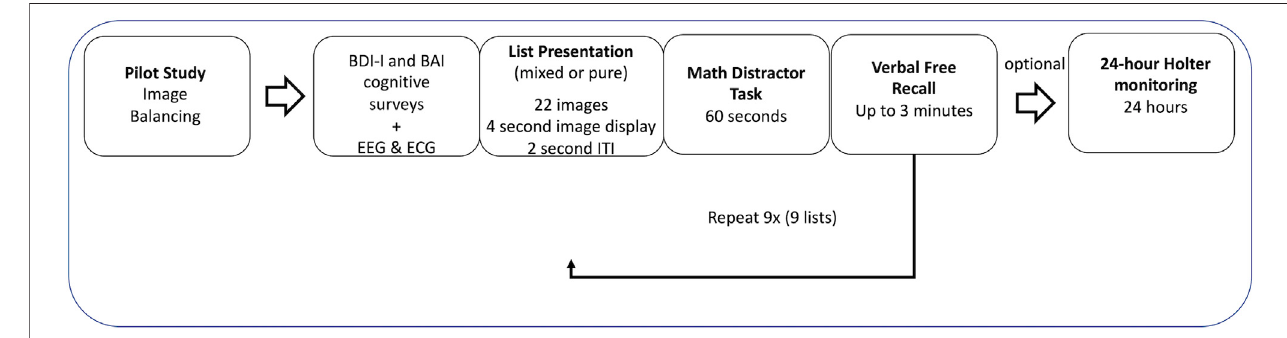
FIGURE 1 | Experimental